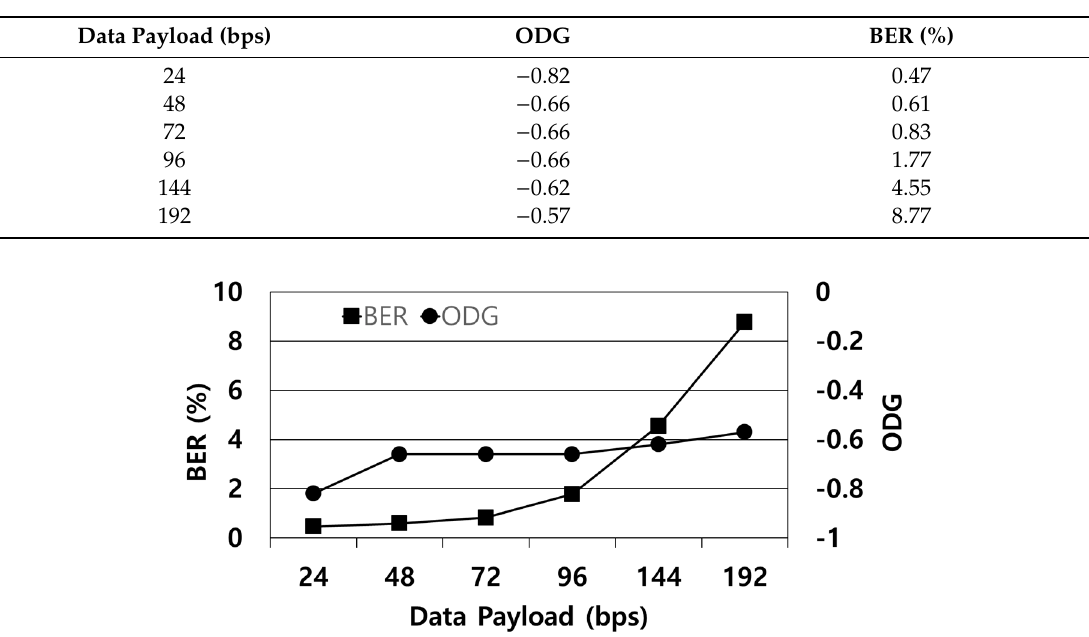
Table 2. ODG and bit error rate (BER) values under various data payloads.